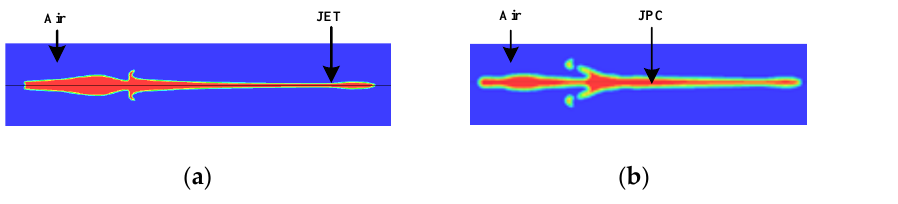
Figure 10. Shapes of different types of penetrators: ( a ) JET; ( b ) JPC; ( c ) EFP.